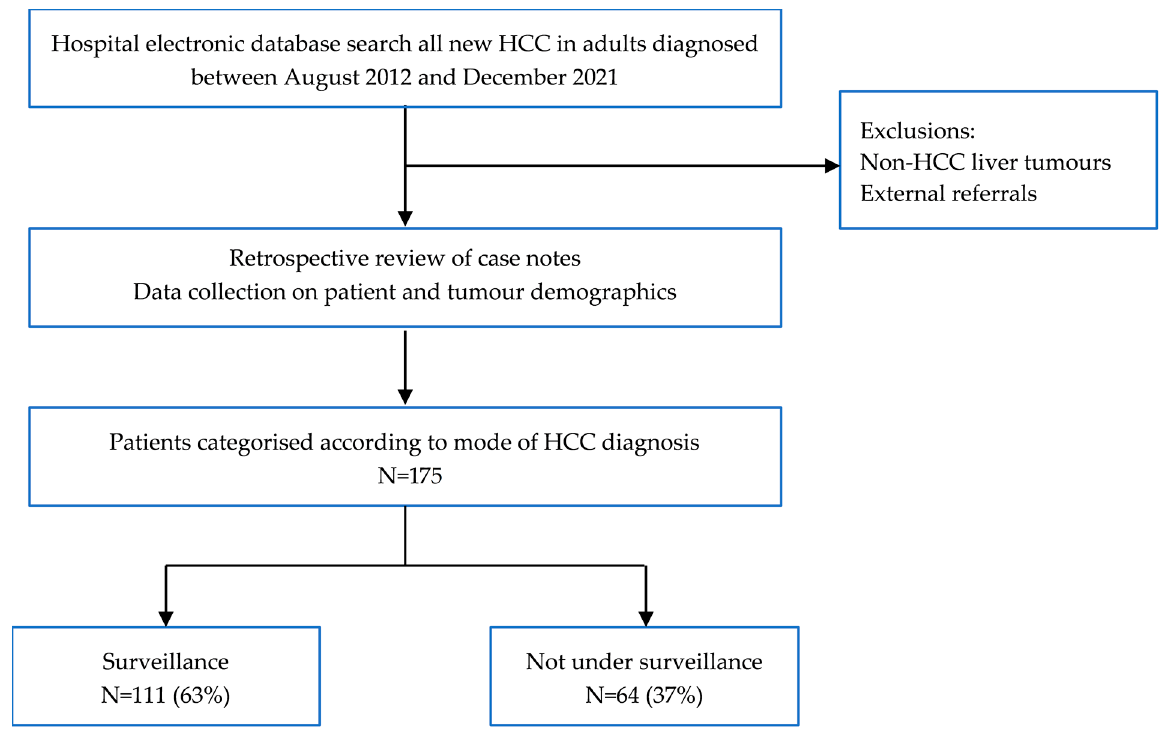
Figure 1. Patient selection for study.